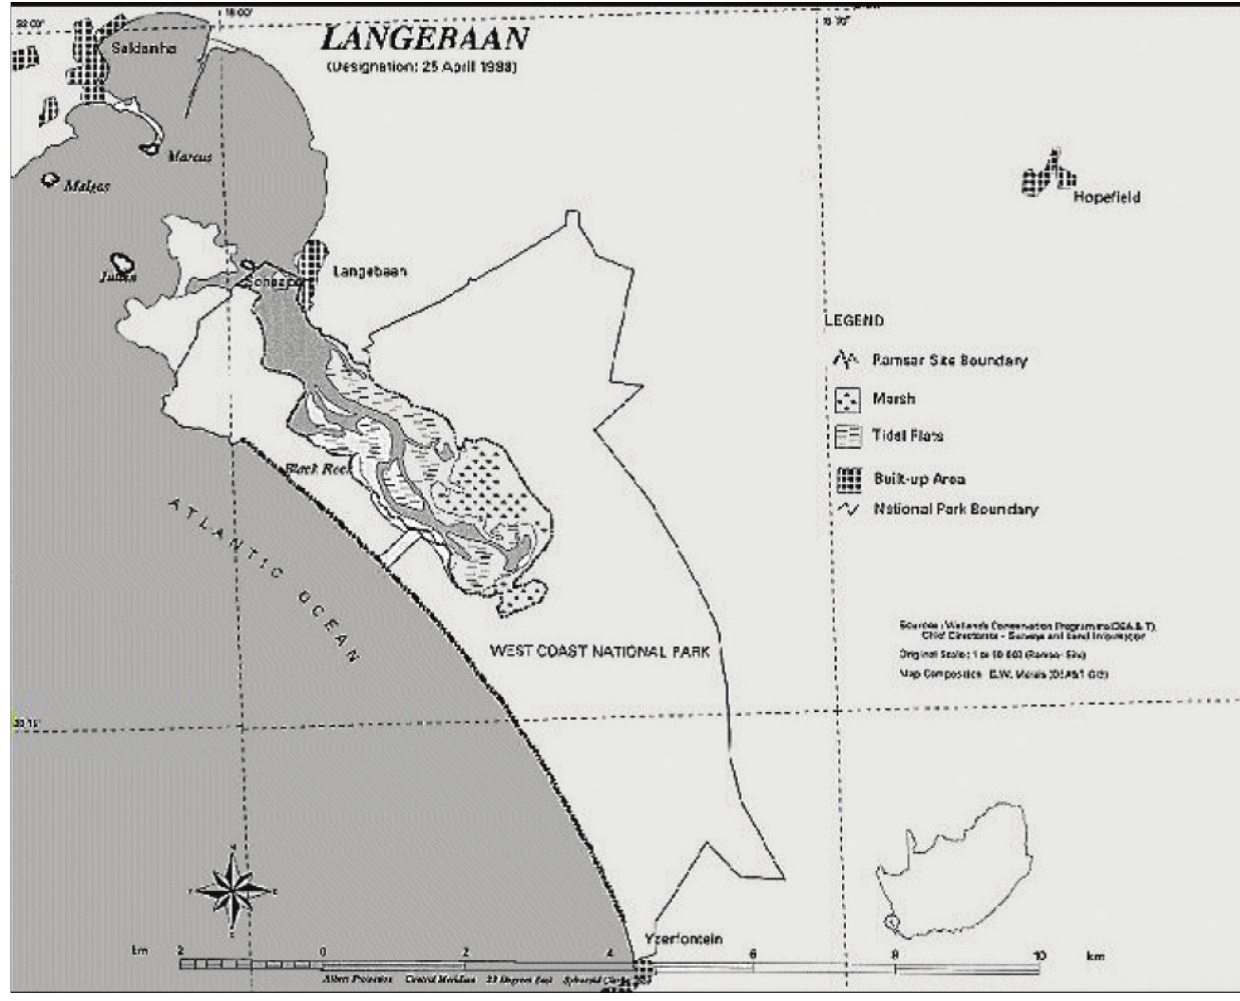
FIGURE 1: Original map of the designated Langebaan Ramsar wetland